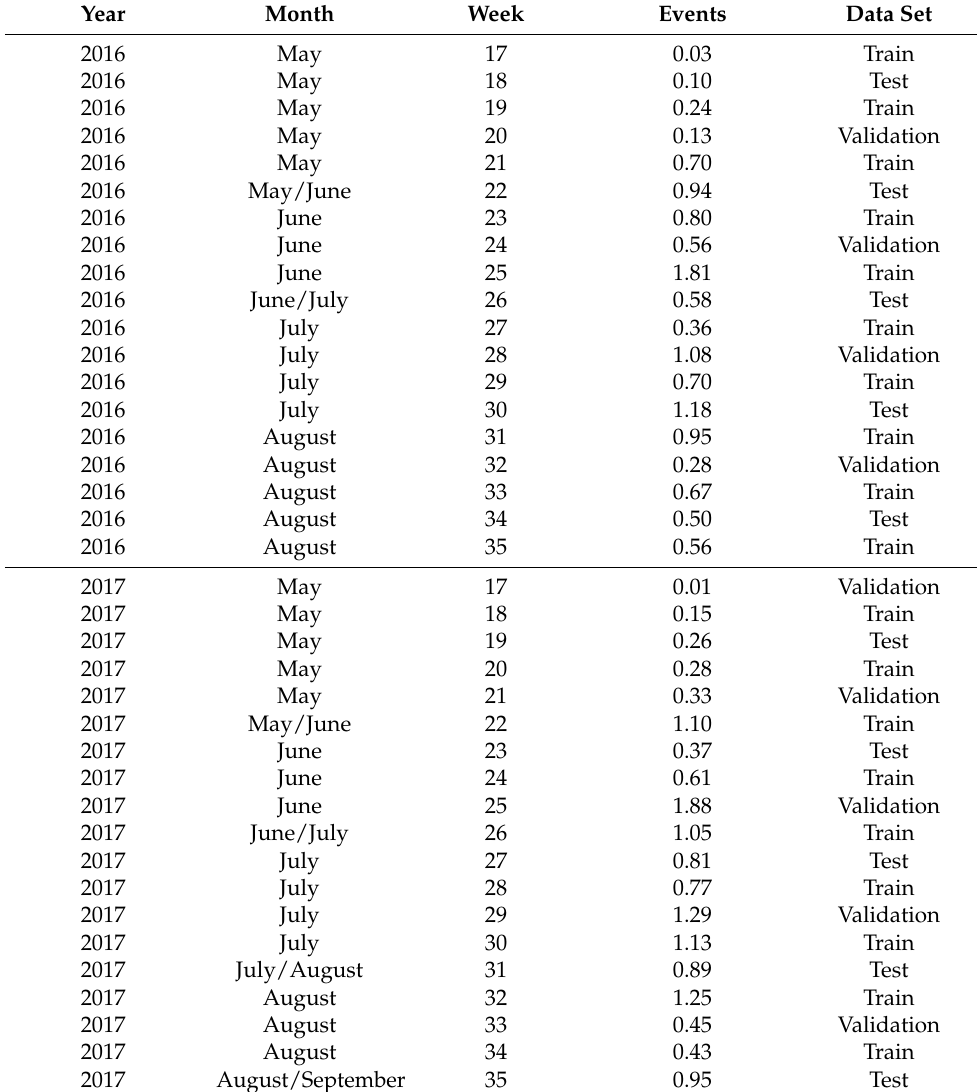
Table A1. Train, test, and validation splits for 2016/2017 data set. Events are shown in millions ( × 10 6 ) in the area (2.0 ◦ W–21.5 ◦ E, 44.5 ◦ N–57.5 ◦